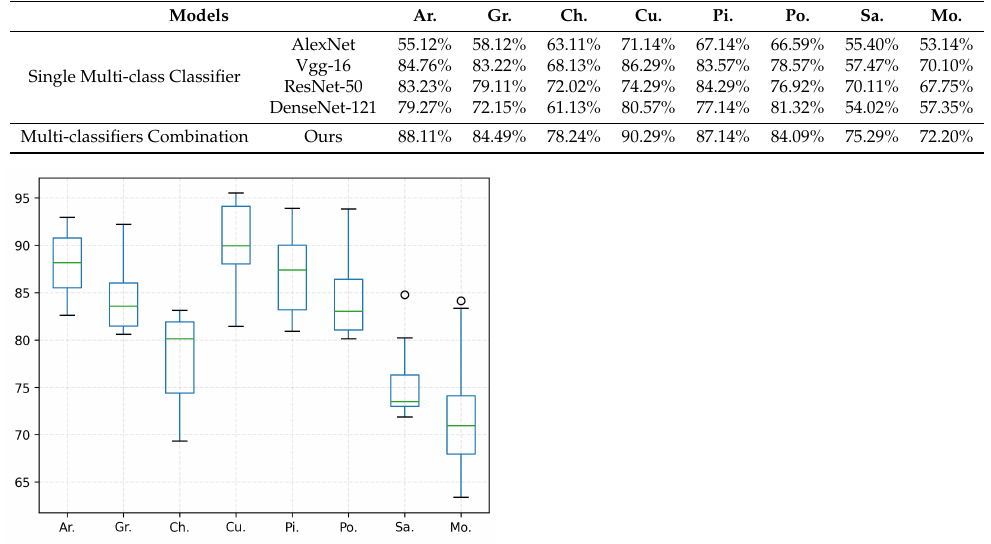
Figure 8. The boxplot of the dispersion of ten-fold cross-validation experimental results across different pollen